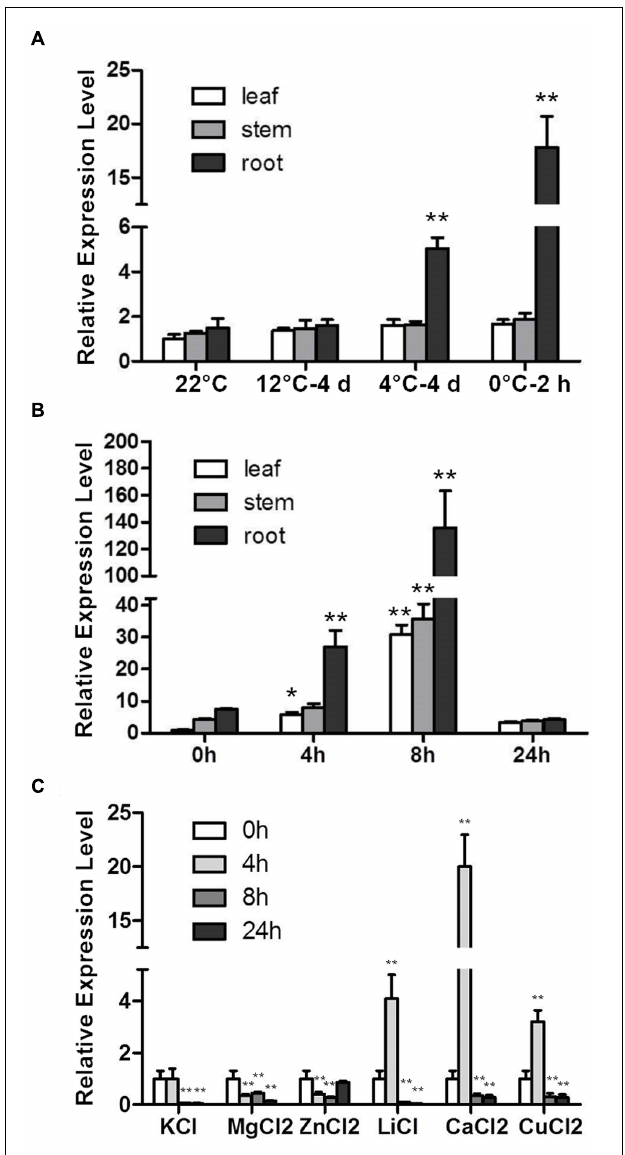
FIGURE 1 | Induction of CbRCI35 in Capsella bursa-pastoris plants under different treatments. (A) The CbRCI35 expression was analyzed in leaves, roots and stem in 4-week-old plants growing at 22 ◦ C after shifting to 12 ◦ C for 4 days, 4 ◦ C for 4 days and 0 ◦ C for 2 h in turn. (B) The CbRCI35 expression in leaves, roots and stem in 4-week-old plants growing at 22 ◦ C was tested after treatments at 4 ◦ C for 0, 4, 8, and 24 h. (C) The CbRCI35 expression was examined in 2-week-old seedlings after treatments with different proton solutions at normal temperature for 0, 4, 8, and 24 h. CbActin gene was used as a housekeeping control. Expression levels were relative to control condition in each tissue. Data are means ± SD ( n = 3, ∗ P < 0.05, ∗∗ P < 0.01).